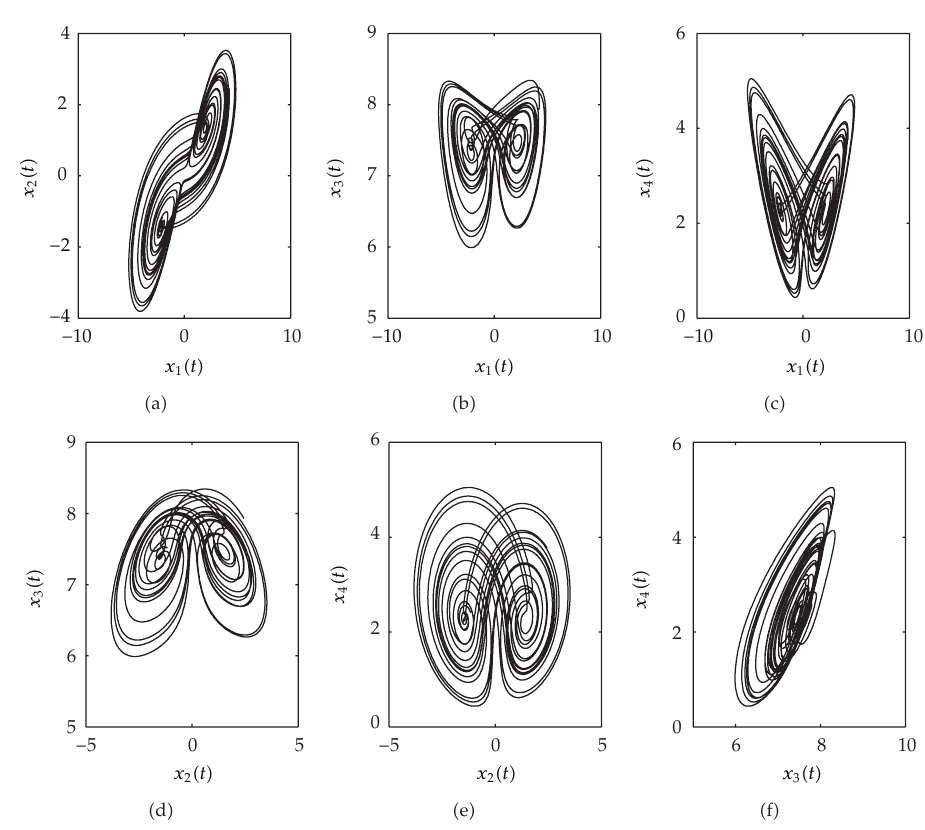
Figure 6: Phase plots for the chaotic case of the hyperchaotic Chen system with a (cid:9) 35 , b (cid:9) 10 , c (cid:9) 1 , d (cid:9)